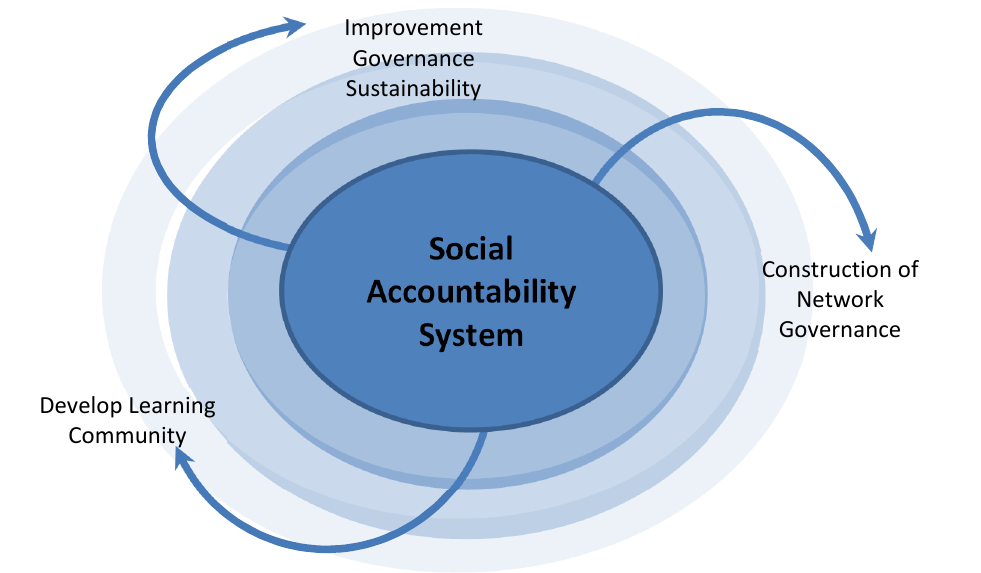
Figure 1: The impact of Social Accountability System in the School